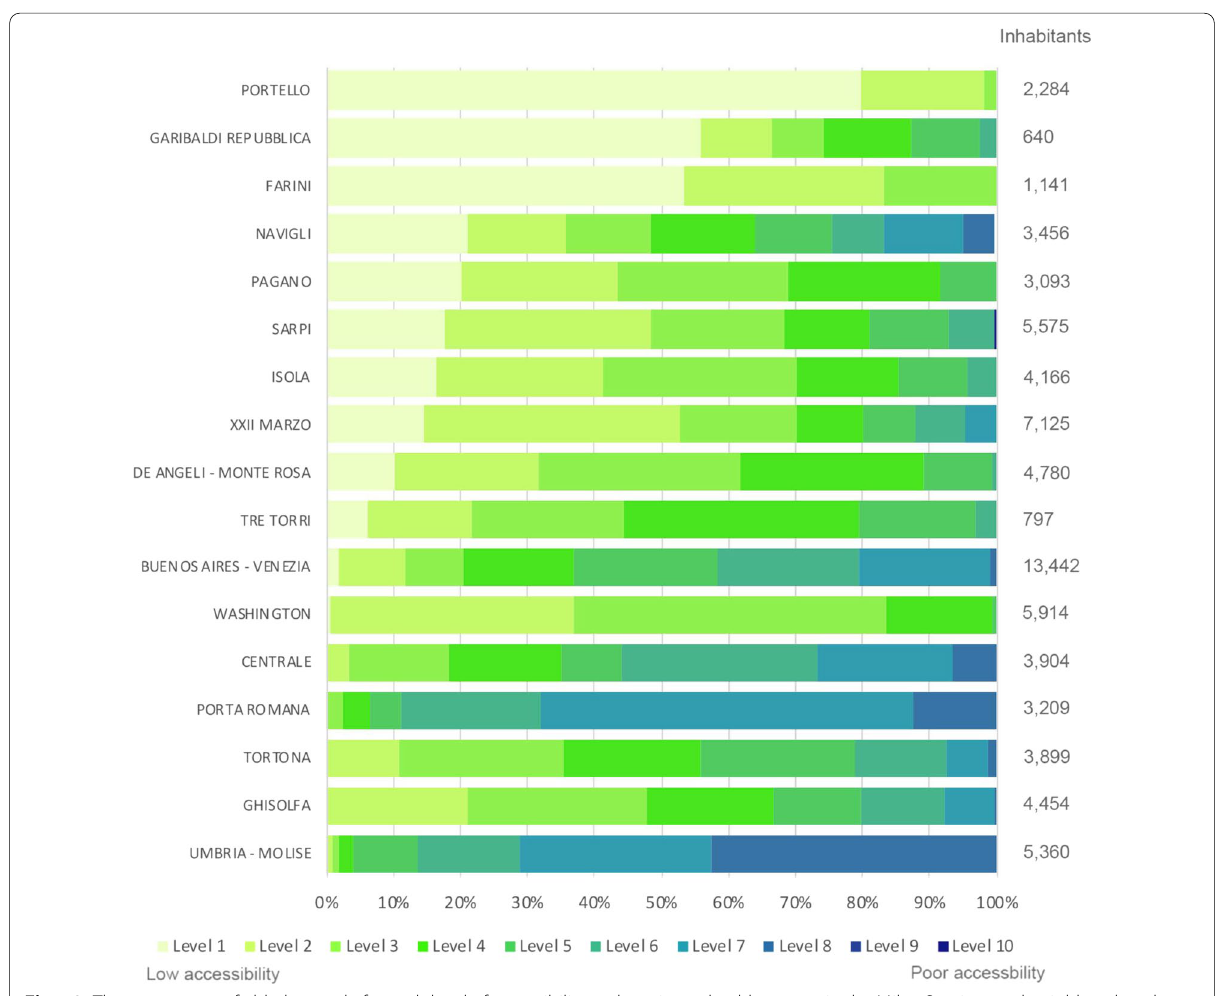
Fig. 10 The percentage of elderly people for each level of accessibility at the primary health centres in the Milan Semi-central